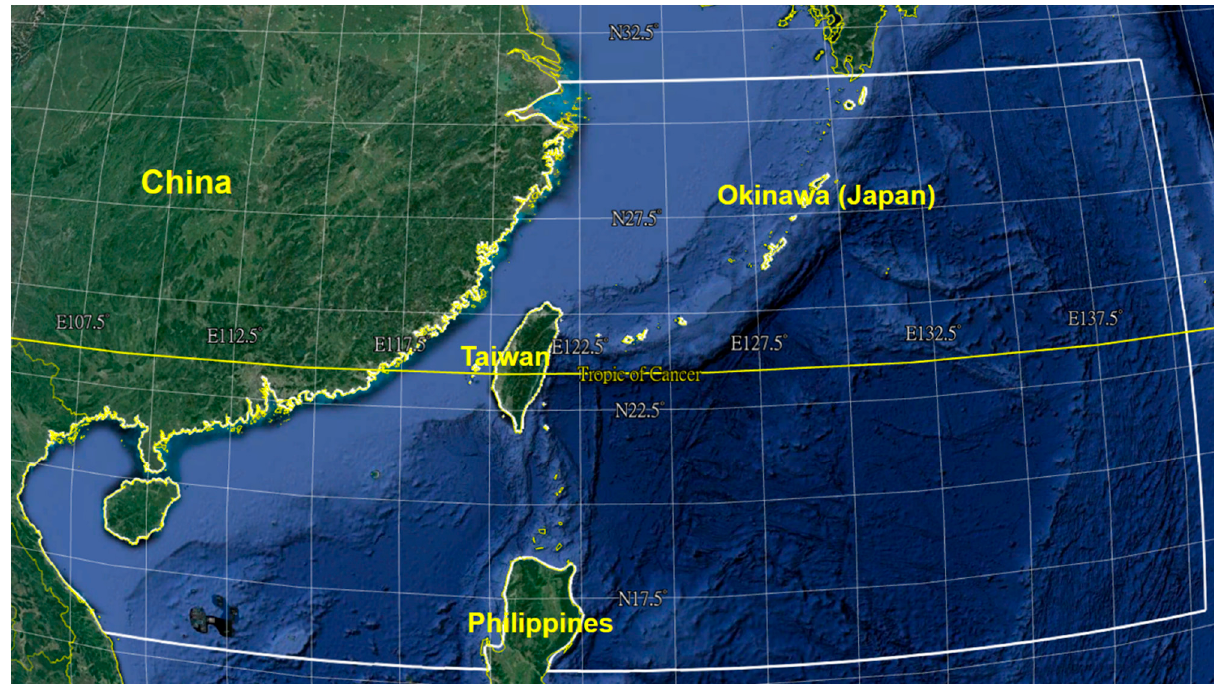
Figure 2. Coverage of the computational domain for the wave-circulation modeling system. Eight main tidal constituents (M 2 , S 2 , N 2 , K 2 , K 1 , O 1 , P 1 and Q 1 ) extracted from a re-